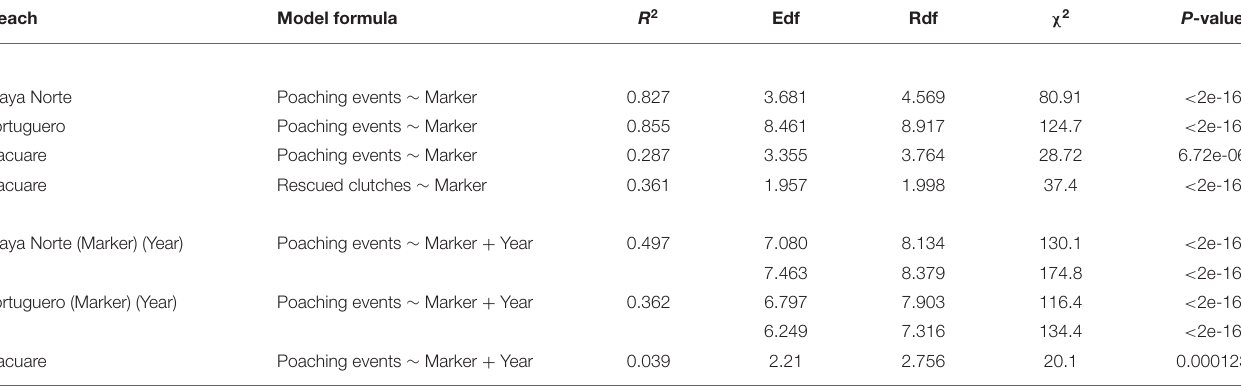
TABLE 2 | The most parsimonious models for the spatial data with binomial distribution for poaching of clutches at each beach against (a) mile marker and (b) year (Edf, Estimated degrees of freedom; Rdf, Relative degrees of freedom). Beach Model formula R